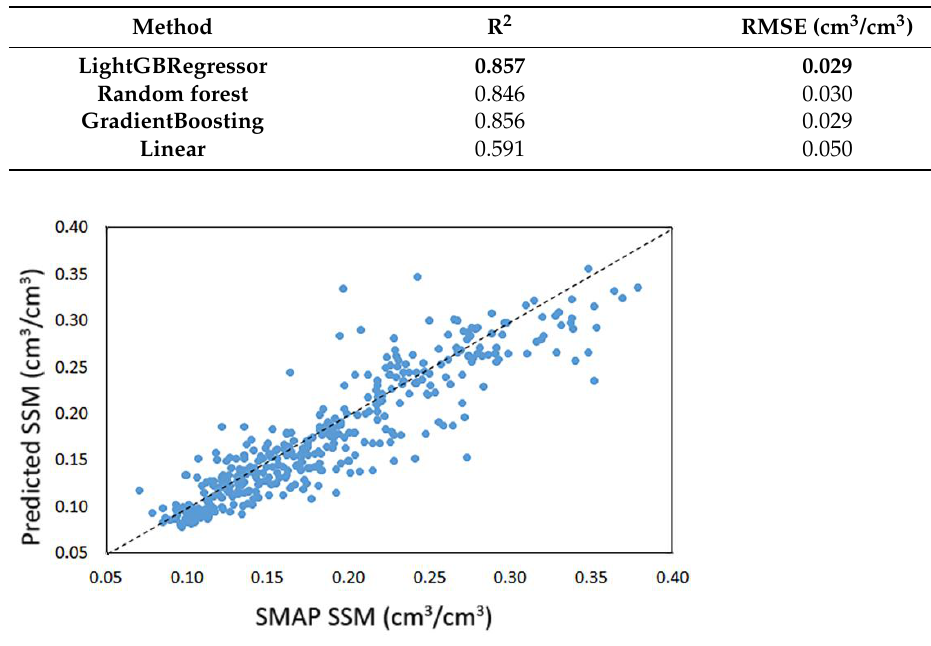
Figure 3. Comparison between LightGBRegressor predictions and SMAP SSM at 9-km grid cells (R 2 0.857; RMSE 0.029 cm 3 /cm 3